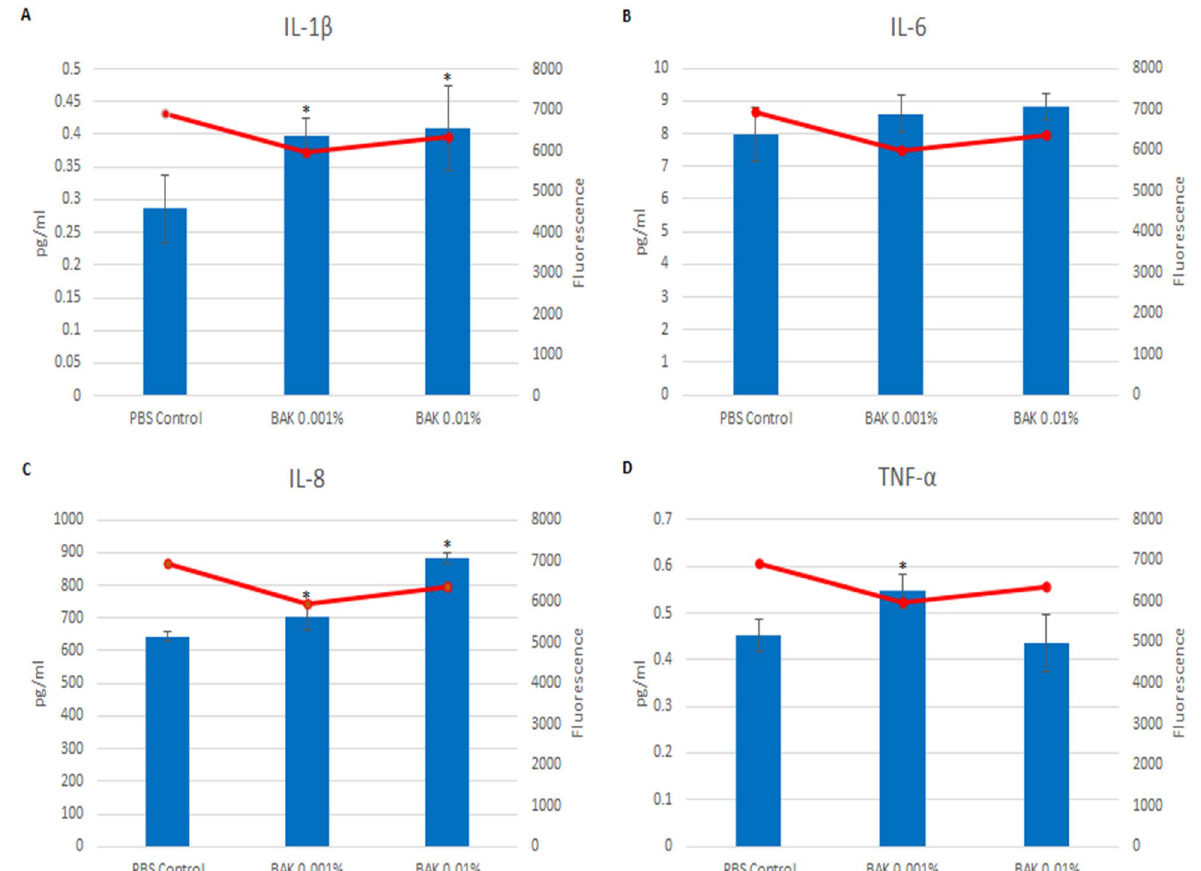
Figure 6. Cytokine release of BAK exposed HLEC. Release of four proinflammatory cytokines (bar graphs) and metabolic activity (line graphs) of HLEC exposed to BAK treated silicone discs. The four cytokines quantified are IL-1β ( A ), IL-6 ( B ), IL-8 ( C ), and TNF-α ( D ). *p < 0.05 of the PBS control. Error bars are the standard deviations. Experiments performed in triplicate in two separate